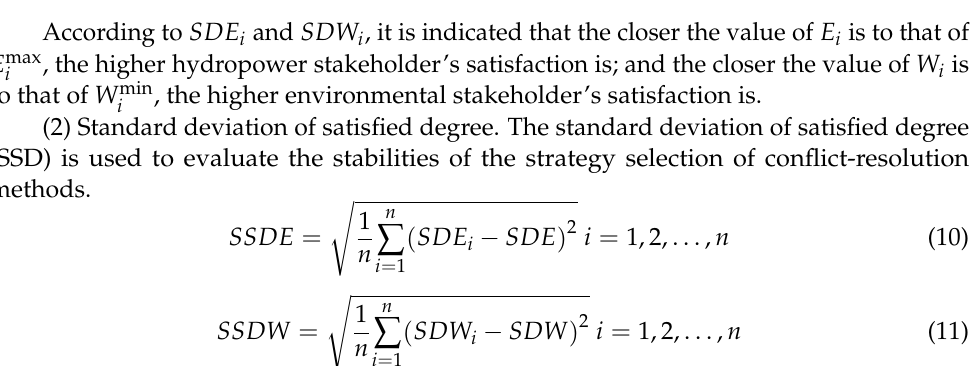
Figure 3. Illustration of the calculation of the satisfied degrees of hydropower stakeholder and environmental stakeholder.